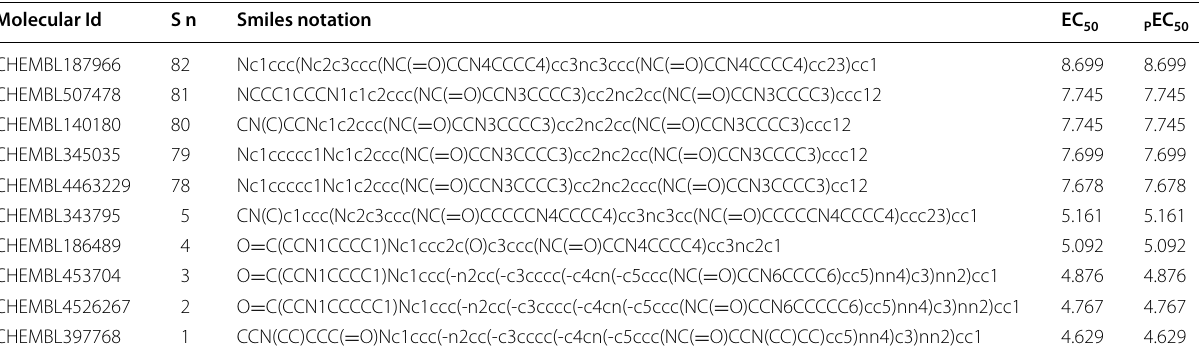
Table 1 Five most and least active Acridine containing heterocycles against Human TERT enzyme (organized according to EC values) Molecular Id S n Smiles